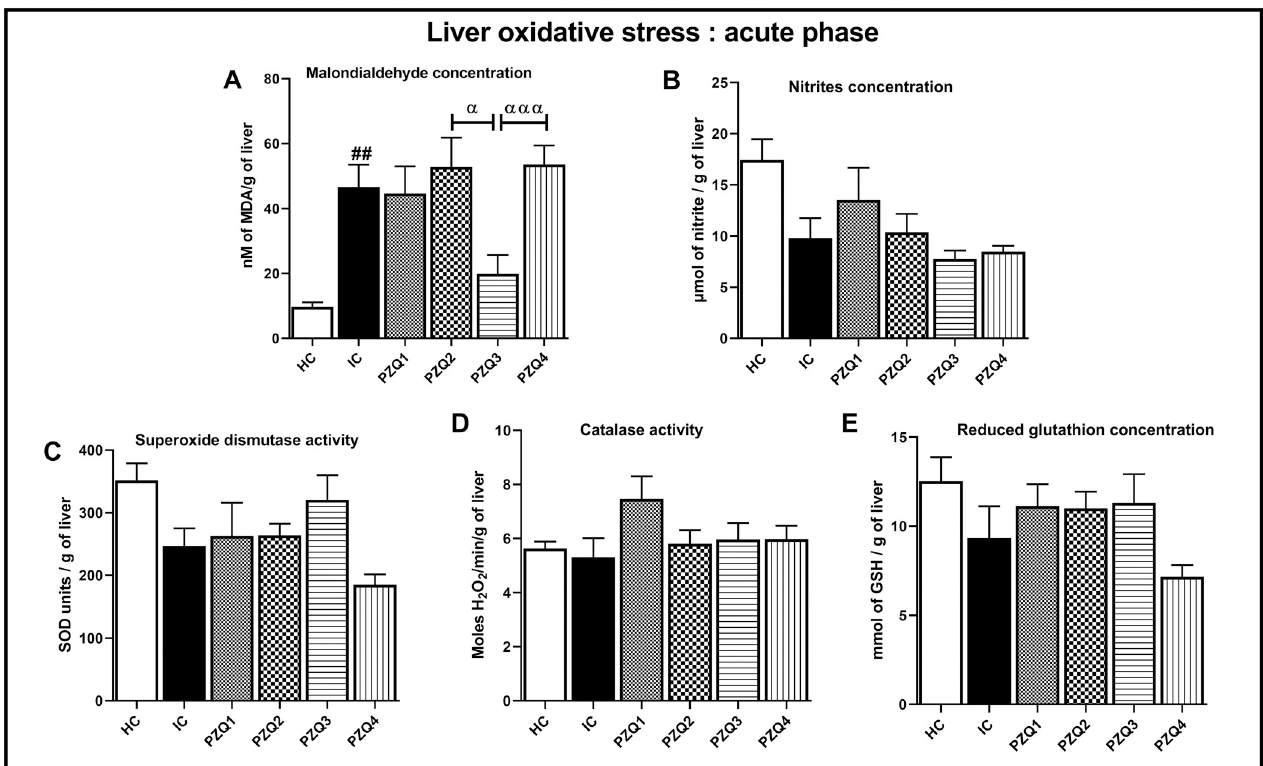
Fig 4. Effect of praziquantel treatment on the liver oxidative status during the acute phase in Schistosoma mansoni -infected mice. (A) malondialdehyde, (B) nitrites, (C) superoxide dismutase, (D) catalase, and (E) Reduced glutathione. HC: Uninfected mice, IC: Infected-untreated mice, PZQ1: Infected mice treated with praziquantel at 100 mg/kg for 5 consecutive days, PZQ2: Infected mice treated with praziquantel at 100 mg/kg for 28 consecutive days, PZQ3: Infected mice treated with praziquantel at 18 mg/kg for 28 consecutive days, PZQ4: Infected mice treated with a single dose of praziquantel at 500 mg/kg. Data are expressed as mean ± SEM (n = 6). ANOVA followed by Tukey multiple comparison test was also used for statistical analysis. ## p < 0.01: values are significantly different from those uninfected mice (group HC). α p < 0.05, ααα p < 0.001: values are significantly different from those of infected mice treated with PZQ3 posology (group